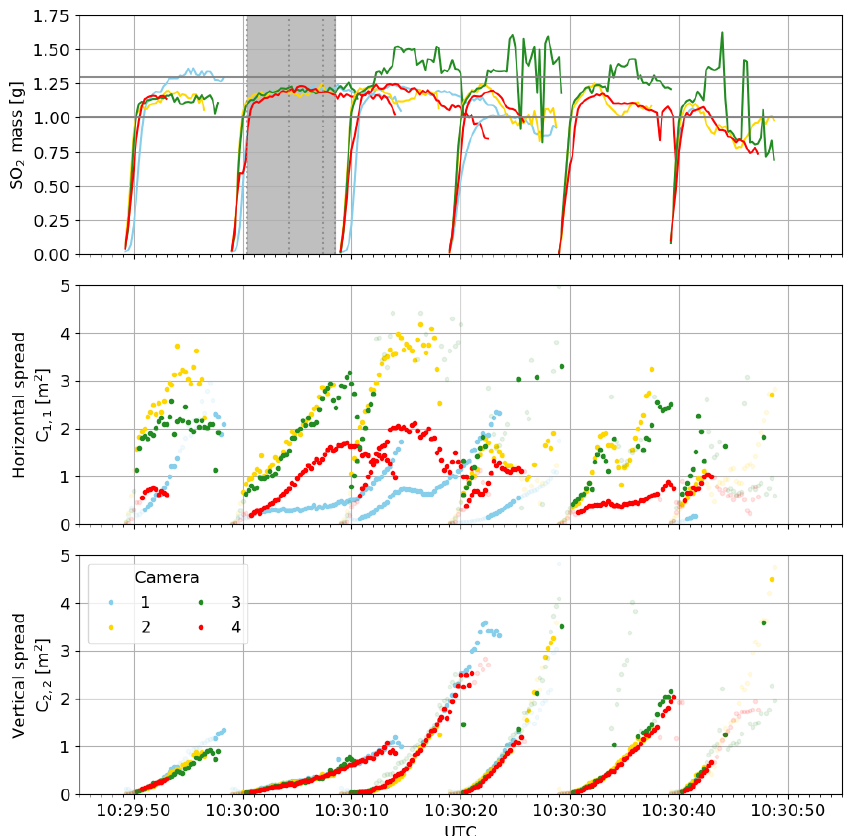
Figure 11. Total mass, horizontal spread and vertical spread (lower panel) of six subsequent puffs. Only data from cameras 1–4 are shown due to significant cloud signals in camera 5 and 6. The background images, and thus cloud cover, were reconstructed from the shaded time period. The shaded data points are discarded because their corresponding mass lies outside the expected range (1.0–1.3g).